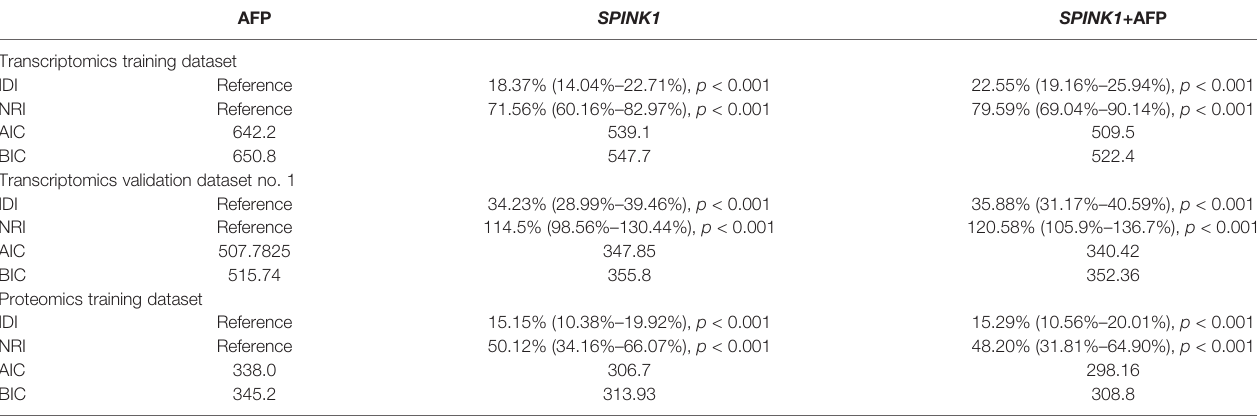
Comparison of the discrimination and goodness of fi t of three predictive models for HCC in the different datasets. IDI, integrated discrimination improvement; NRI, net reclassi fi cation improvement; AIC, Akaike information criterion; BIC, Bayesian information